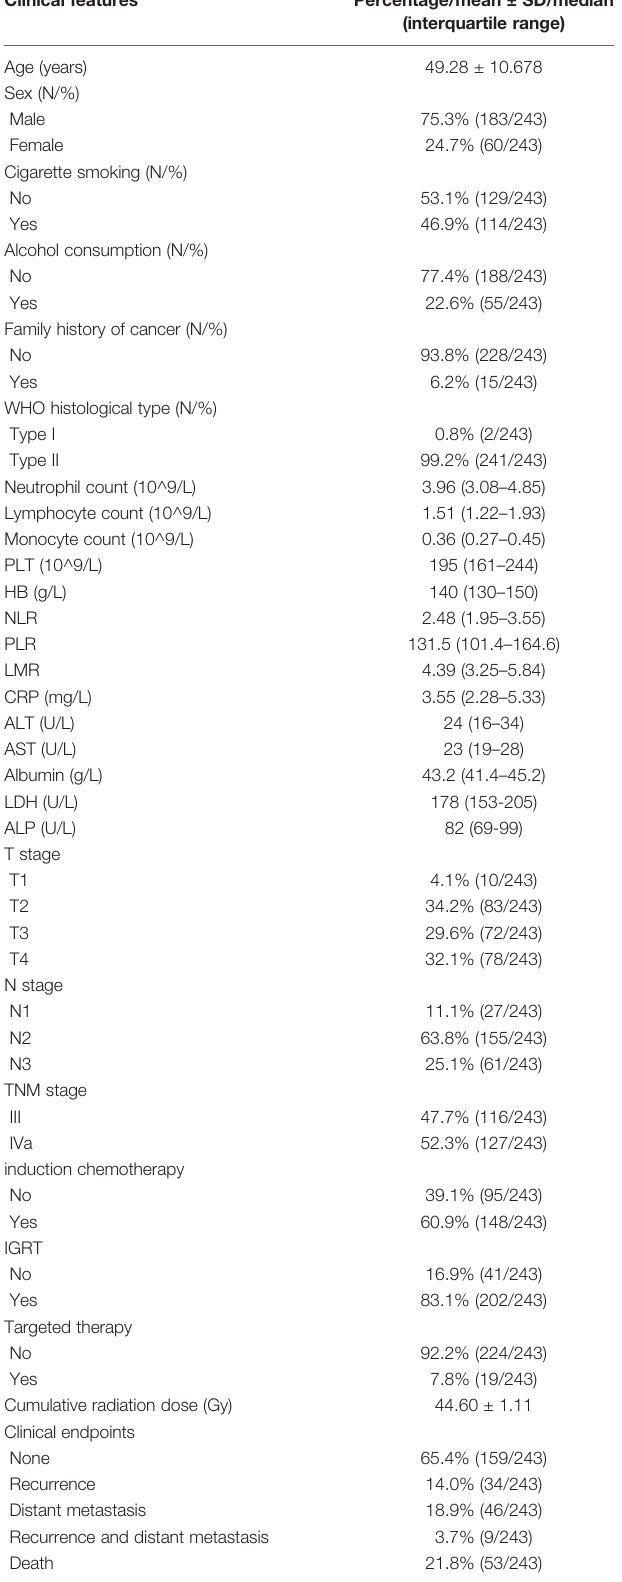
TABLE 1 | Clinical baseline data of the subjects